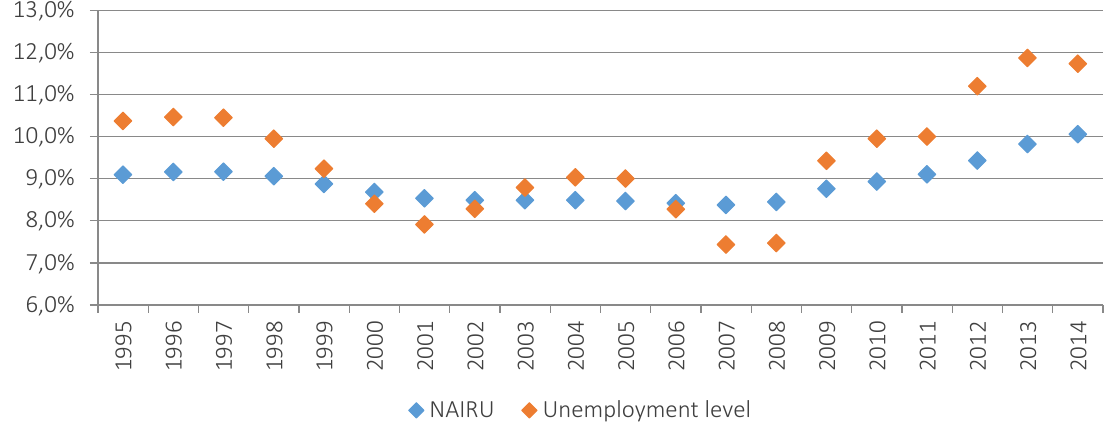
Figure 2. The unemployment rate in the Eurozone countries